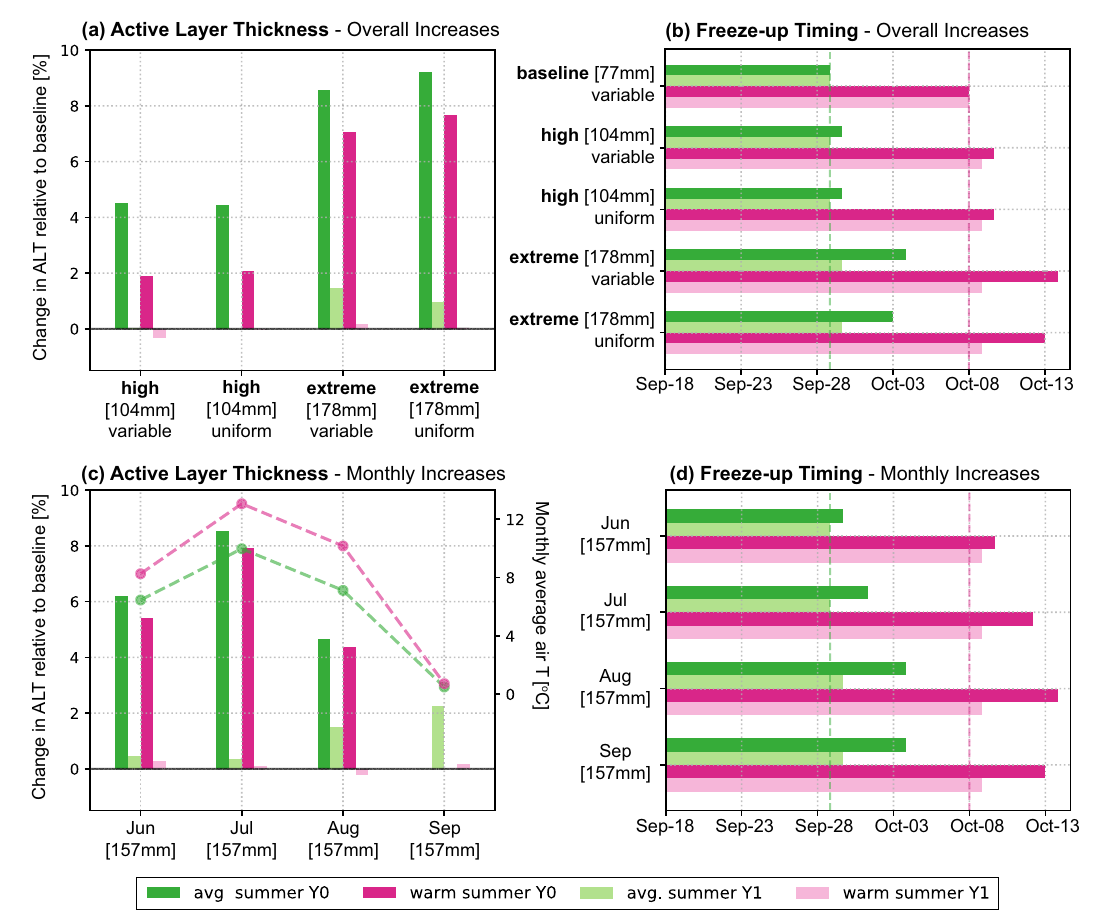
Fig. 3 Effect of rainfall and temperature scenarios on modelled thaw dynamics. Effect of rainfall scenarios on active layer dynamics in average (green) and warm (pink) summers, for the year of altered rainfall (Y0, dark shades) and the year after (with baseline conditions) (Y1, light shades). a Modelled percentual difference in active layer thickness (ALT) under increased June – August (JJA) rainfall, with either uniform increase of JJA rainfall or variable increase (modelled to follow observed frequency-intensity distribution). b Modelled timing of complete freeze-up of the soil column under increased JJA rainfall. c Modelled percentual difference in ALT under increased rainfall in particular months. Dashed lines indicate mean temperature during the month of rainfall addition in average (green) and warm (pink) summers. d Modelled timing of complete freeze-up under increased rainfall in particular months. Changes (%) in ALT ( a , c ) are reported relative to baseline rainfall under the corresponding temperature scenario (average or warm summer). Positive changes percentages indicate increased